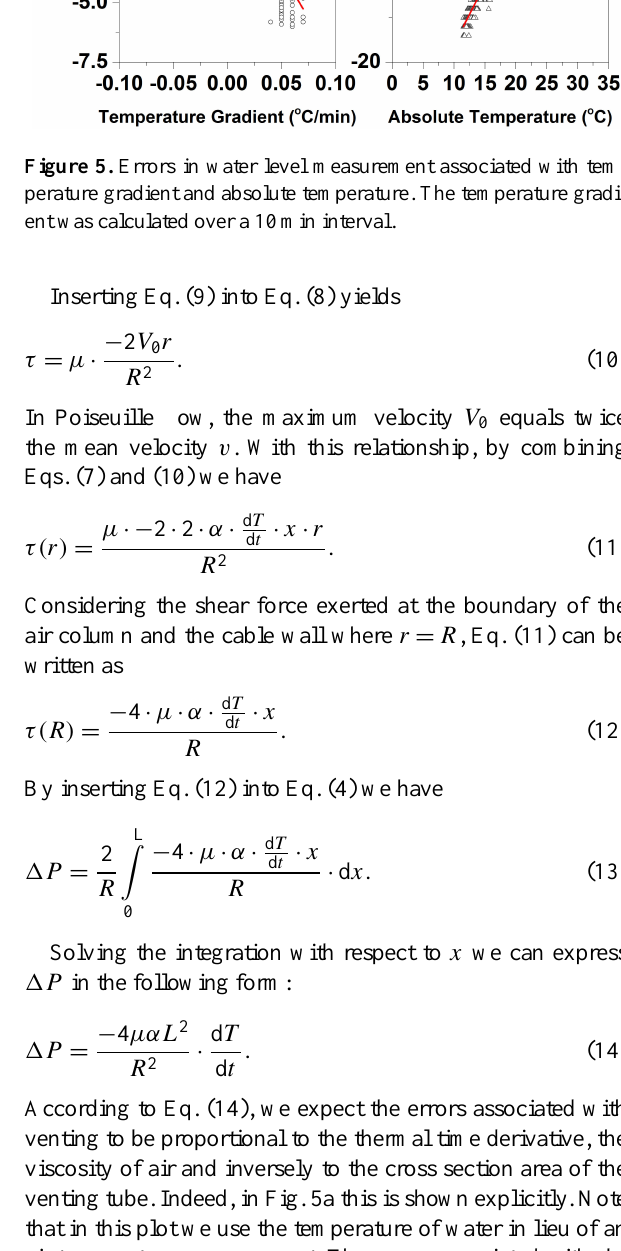
Figure 4. Schematic plot of the air movement inside the venting cable by thermal expansion.